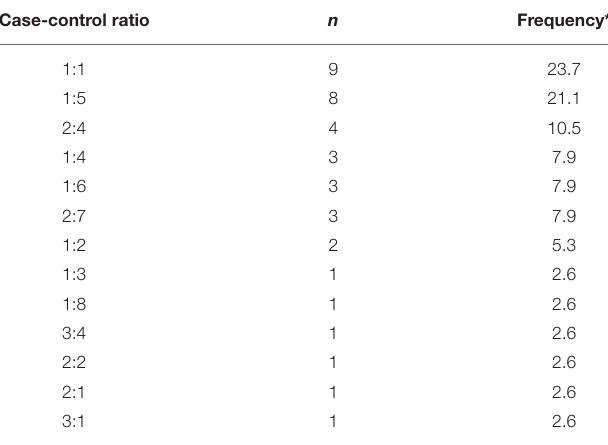
TABLE 1 | Distribution of the ratios used to individually match flocks with isolation of Campylobacter (cases) to flocks with no Campylobacter isolation (controls). Case-control